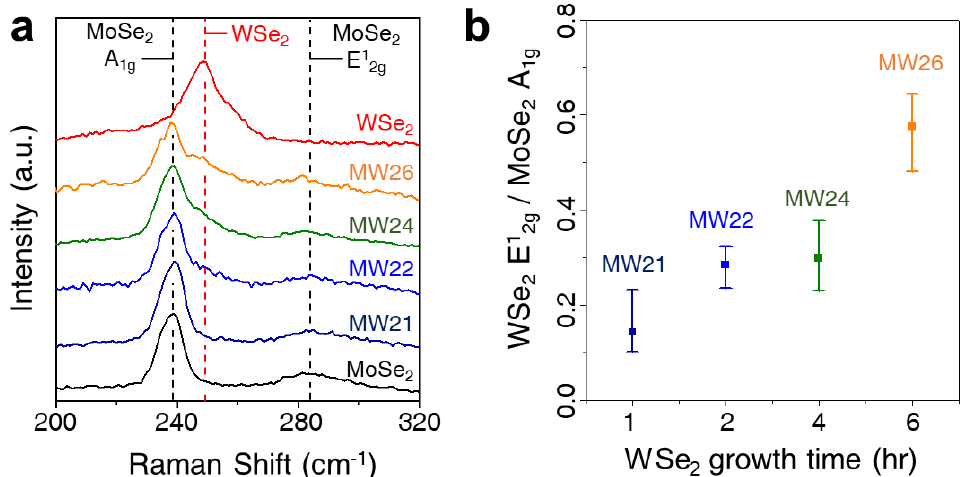
Figure 6. ( a ) Raman spectra of MoSe 2 /WSe 2 heterostructures (MW21, MW22, MW24, and MW26), shown together with the data of pure MoSe 2 and WSe 2 . The vertical dashed black lines correspond to the MoSe 2 A 1g (239 cm −1 ) and E 12g (283 cm −1 ) peaks. The vertical dashed red line denotes the WSe 2 E 12g (249 cm −1 ) peak. ( b ) Raman intensity ratio of WSe 2 E 12g to MoSe 2 A 1g as a function of the secondary WSe 2 growth time.